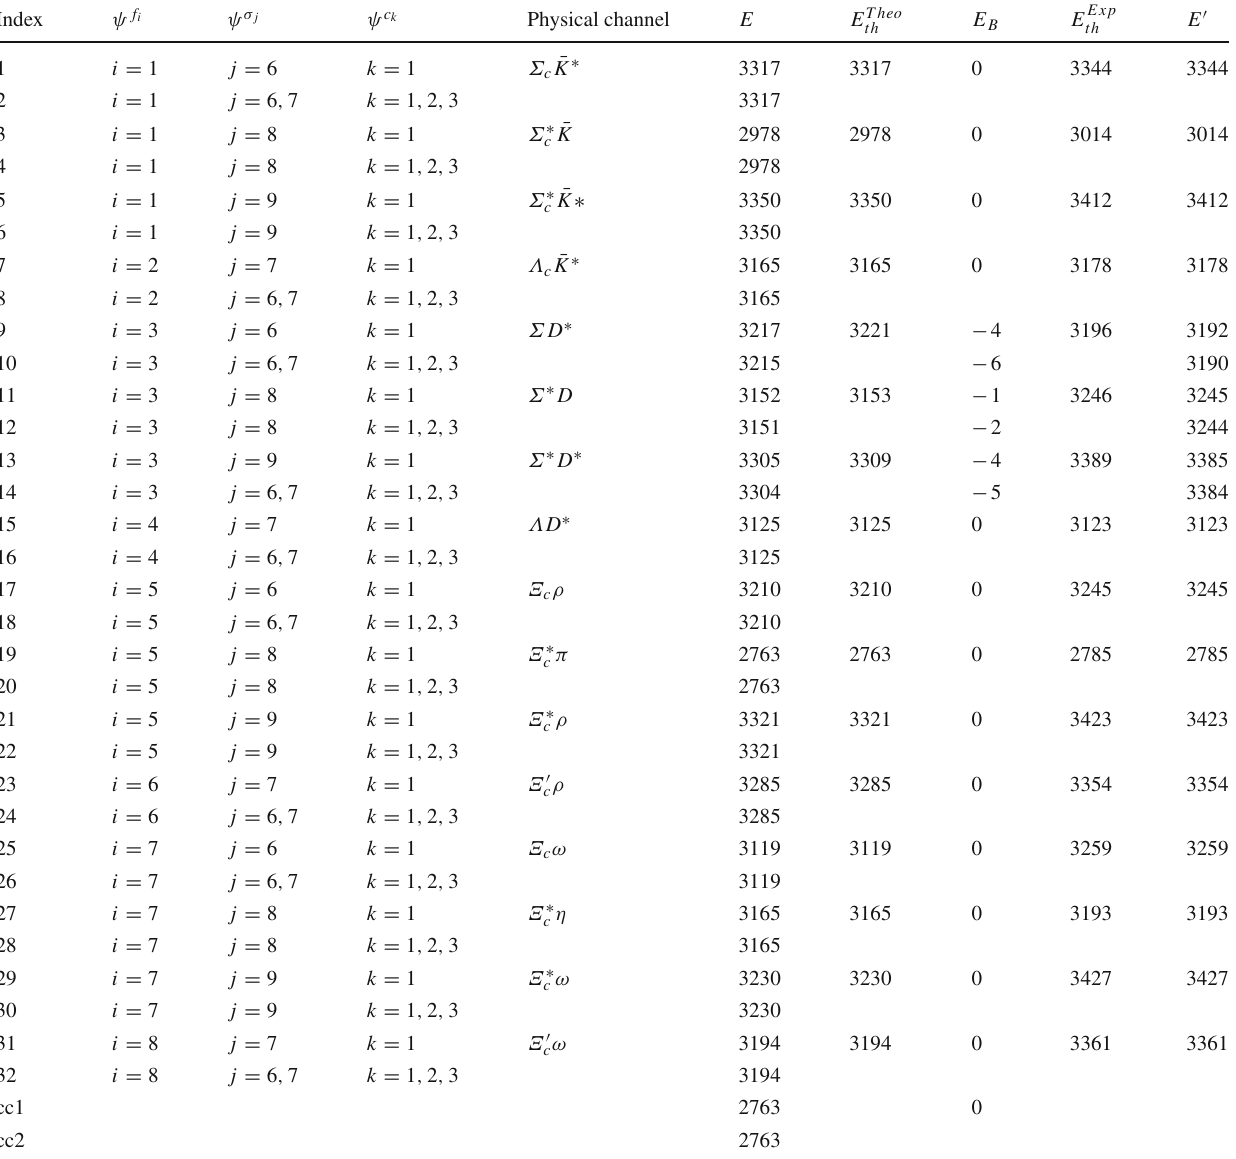
− 3 “cc1” denotes the color-singlet channels coupling and “cc2” means full channels coupling 2 2